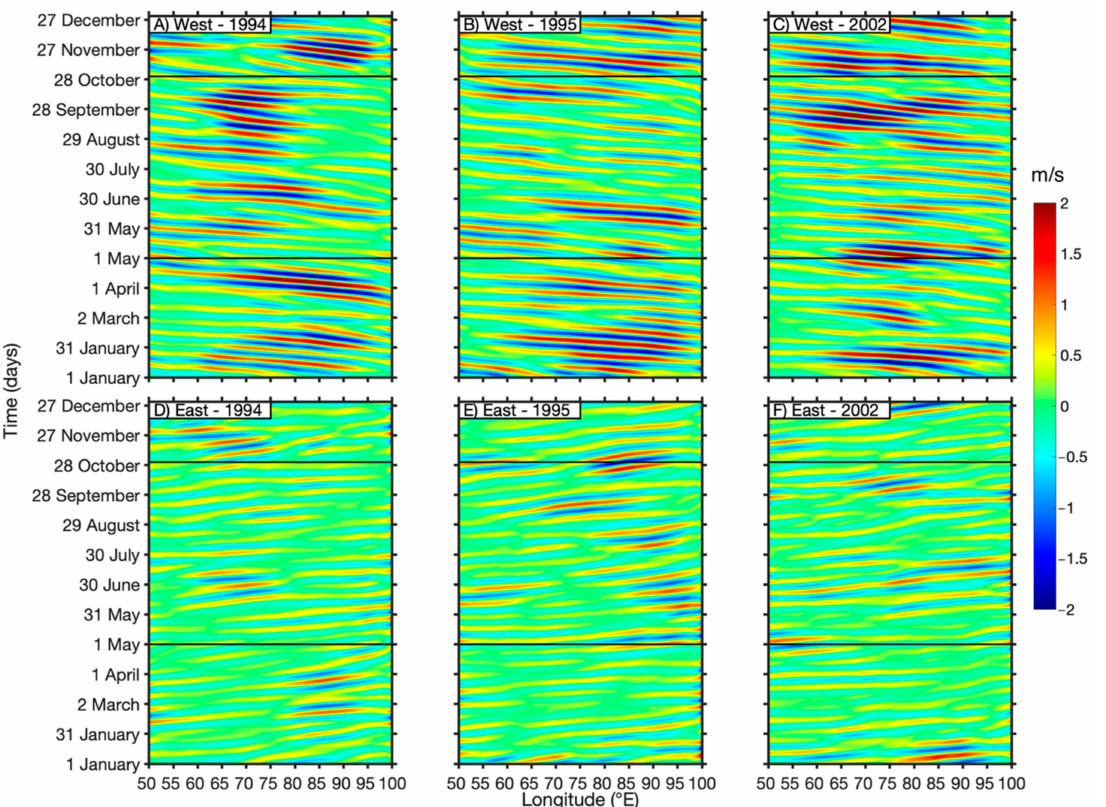
Figure 4. Time–longitude plots of 10–20-day bandpass-filtered meridional surface wind (shaded; m/s) in the equatorial Indian Ocean during a strong ( A , D ), normal ( B , E ), and weak ( C , F ) monsoon season that is filtered for westward ( A – C ) and eastward ( D – F ) propagation. The extended southwest monsoon season (May–October) is indicated by black lines on the plot.